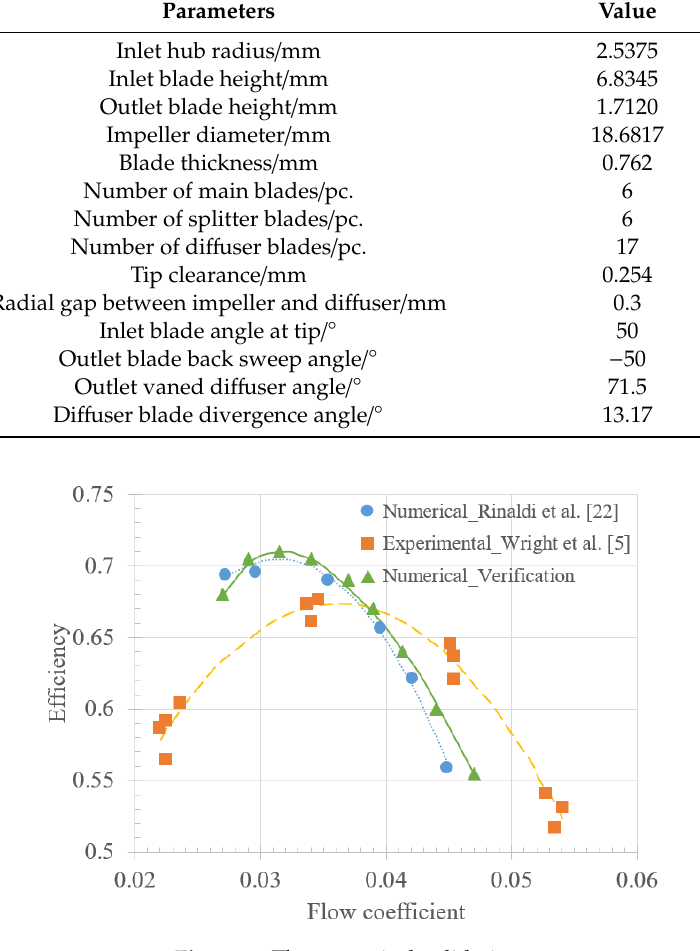
Figure 9. The numerical validation.